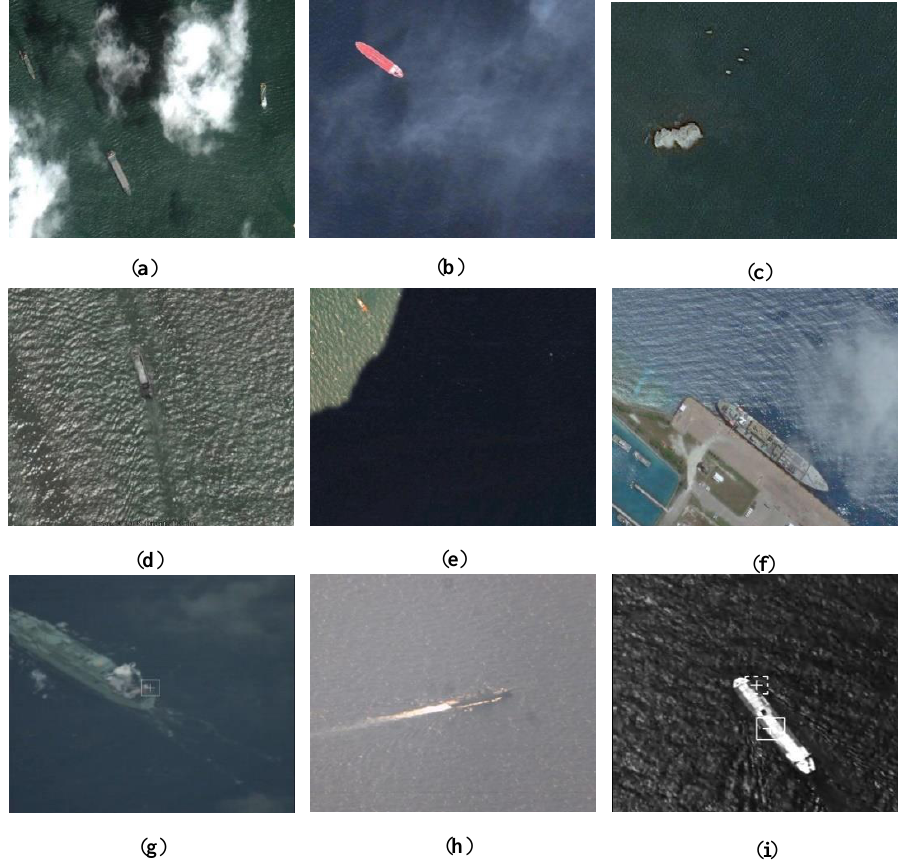
Figure 2. Some optical remote sensing images in DSDR dataset. The background of the ships is particularly complex, the ships are surrounded or blocked by clouds ( a – b ), there is island near the ship ( c ), interference caused by ripple ( d – f ), the effect of uneven lighting ( e ), ship docked at the port ( f ), ships from different perspectives ( g – i ).